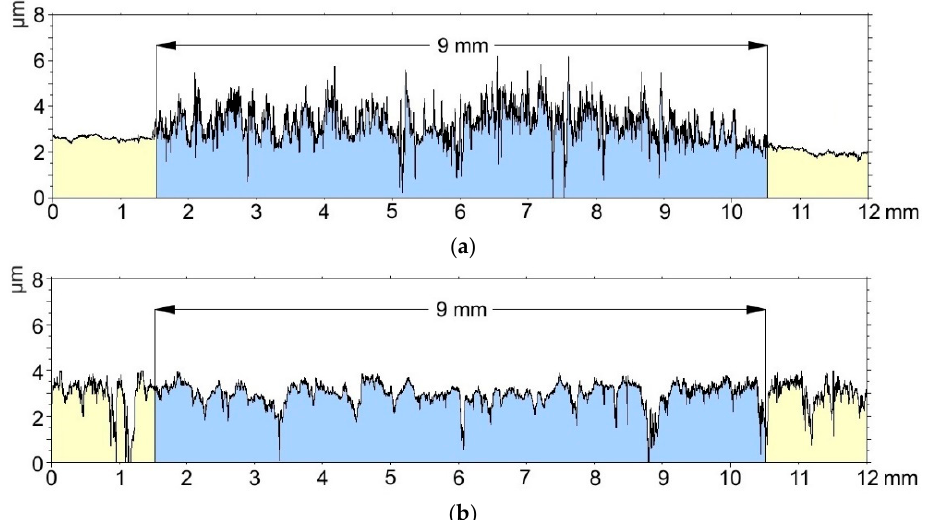
Figure 13. Roughness profiles: ( a ) aluminum alloy EN AW-5251, ( b ) Al 2 O 3 layer. Based on the analysis of the roughness profiles for the aluminum alloy EN AW-5251 without modification and the Al 2 O 3 layer, significant differences are noticeable. Tribopart- ner (T7W material) with a diameter of ϕ 9 mm coincides with the width of the sliding film marked in Figure 6. Before the tribological test, aluminum alloy is characterized by low roughness, but cooperation with the material contributed to a significant increase in roughness and the appearance of a significant number of peaks on the surface, which re- sults in a higher coefficient of friction and uneven overlapping of the sliding film on the friction surface. The sample with the oxide layer before friction had a much greater rough- ness than the aluminum alloy, but the tribological test influenced the smoothing of the sample and filling the cavities in the profile through an evenly superimposed sliding film. Figure 14 shows the roughness profiles before and after the tribological test for the oxide layers with the highest material mass loss (sample E) and the lowest material mass loss (sample H). ( a1 )